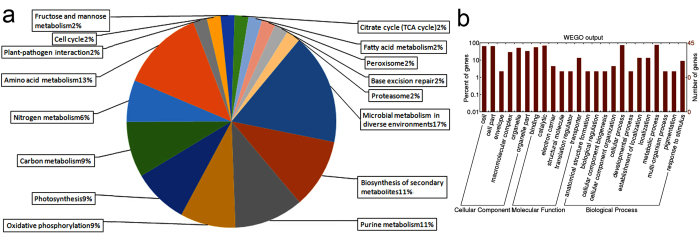
Functional categories of differentially expressed proteins involved in various biological processes.Proteins identified were mapped to KEGG pathways by using KEGG database and homology mapping (a) and WEGO for plotting GO annotation results (b).